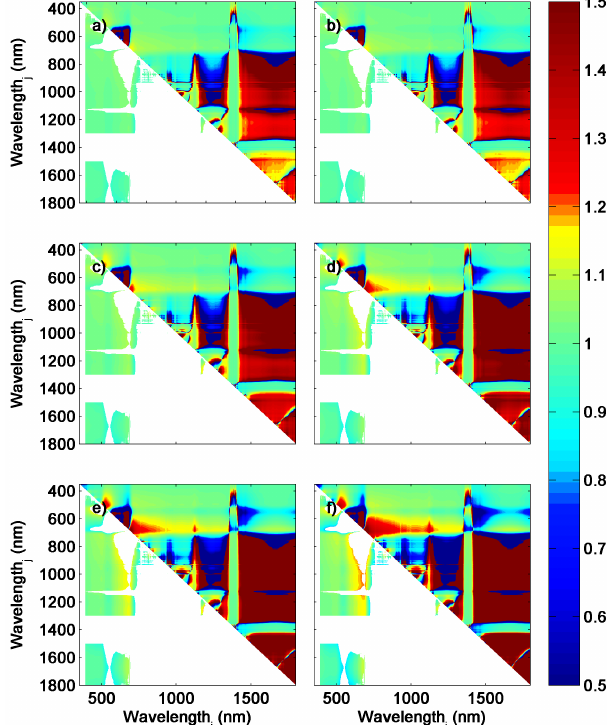
Figure 4. The anisotropy factor (ANIF) for different normalised difference spectral index (NDSI) wavelength ( i,j ) combinations for 15 days at the peak of the growing season 2011 (day of year 237– 251) for the different sensor viewing angles: (a) 15 ◦ E, (b) 15 ◦ W, (c) 30 ◦ E, (d) 30 ◦ W, (e) 45 ◦ E, and (f) 45 ◦ W. In order not to include effects of solar zenith angles in the analysis, only data measured between 12:00 and 14:00 (UTC) were used in the ANIF calculations ( n = 48). The upper right half of each chart shows the unfiltered R 2 values, whereas the lower left half shows filtered R 2 , based on the filtering criteria described in Sect. 2.6.